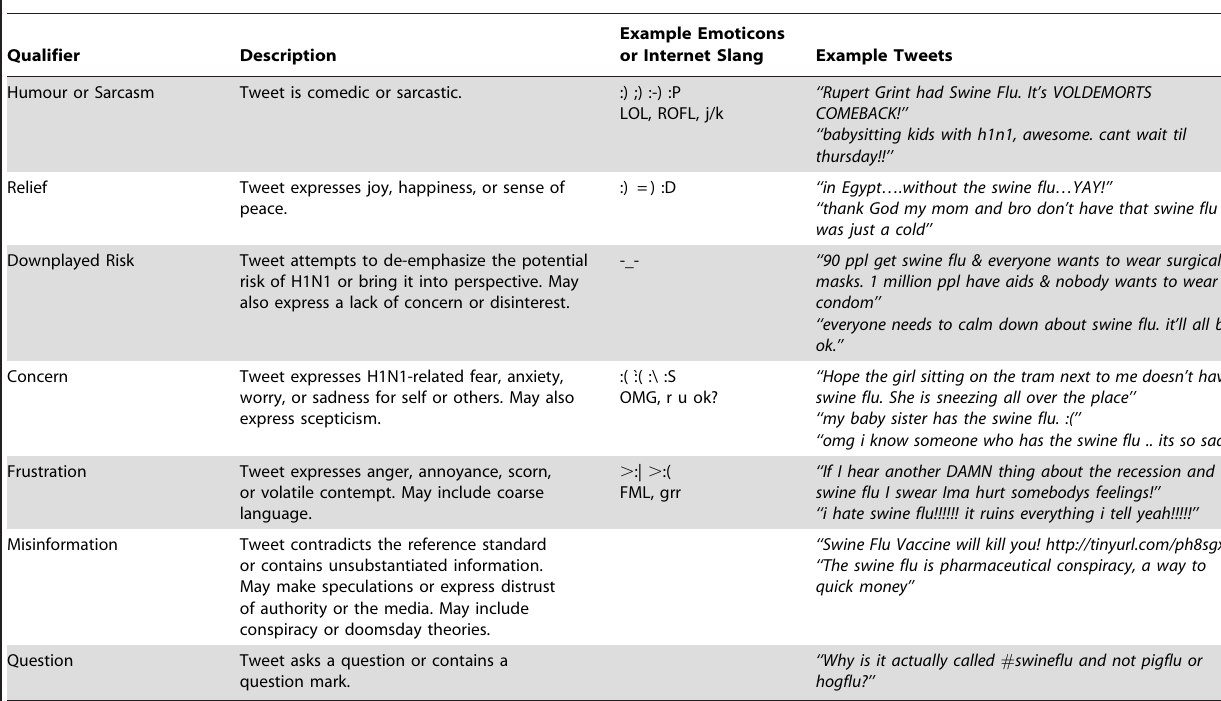
Table 2. Descriptions and Examples of Qualifier Categories.